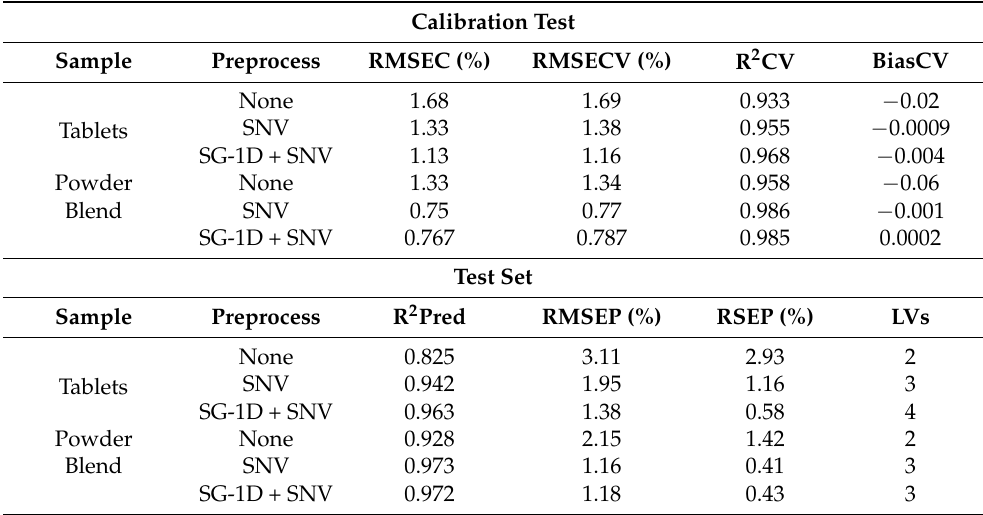
Table 2. MVA results obtained for tablets and powder blends using the PLS models of QCL re- flectance